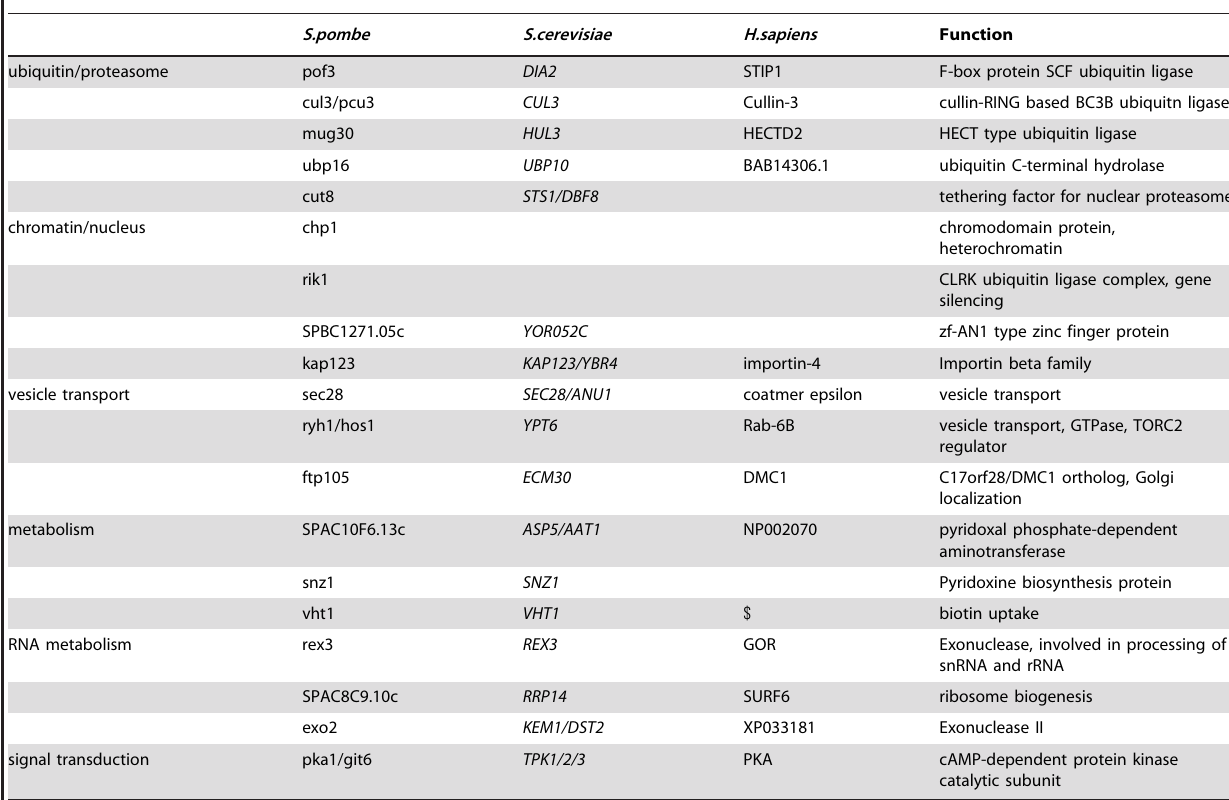
Table 1. List of SLB